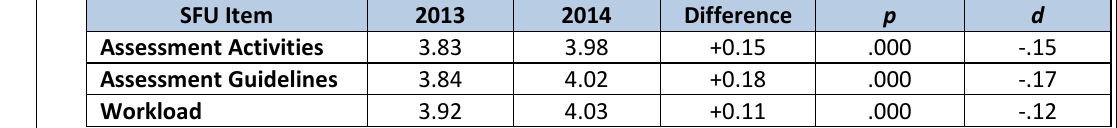
Table 2: Mean satisfaction ratings on SFU items 2013 –